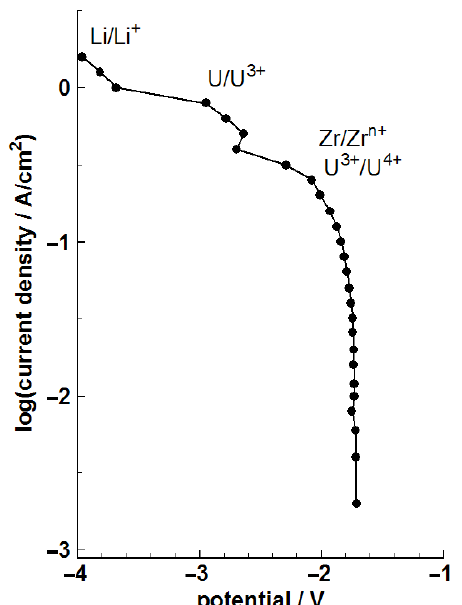
Figure 8. Polarization of liquid Ga–Zn alloy cathode in 3LiCl–2KCl–ZrCl 4 –UCl 4 melt at 534 °C (1.64 wt. % ZrCl 4 , 2.03 wt. % UCl 4 ). Potentials vs. 2Cl − /Cl 2 reference couple.